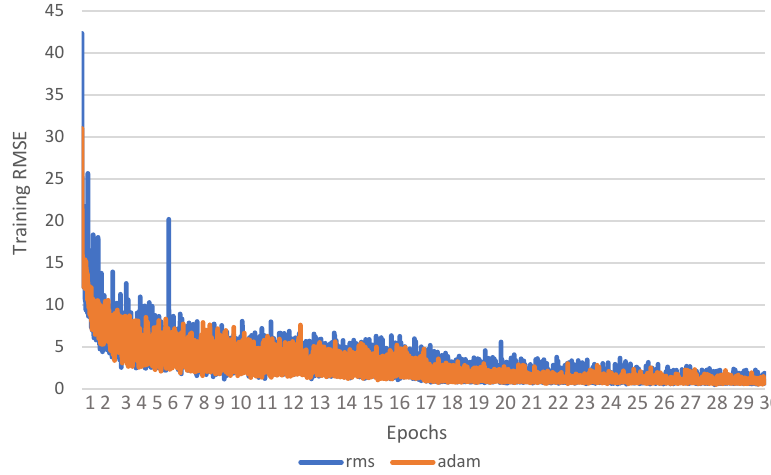
Figure 8. The proposed DCRN training loss function performance with SG layer based different optimizers.